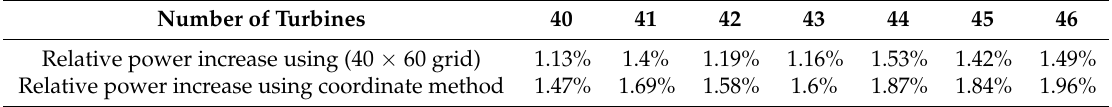
Figure 6. Total wind farm power for different design methods. Table 4. Total wind farm power output increase of different number of wind turbines using refined 40 × 60 grid method and coordinate method with respect to the coarse 20 × 30 grid density.